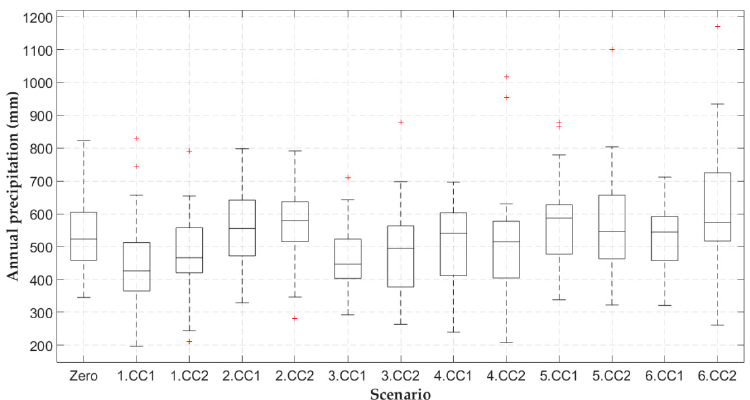
Figure 4. Boxplots for annual precipitation depth under all examined scenarios for Lipsi Island. Table 4. Climatic scenarios.